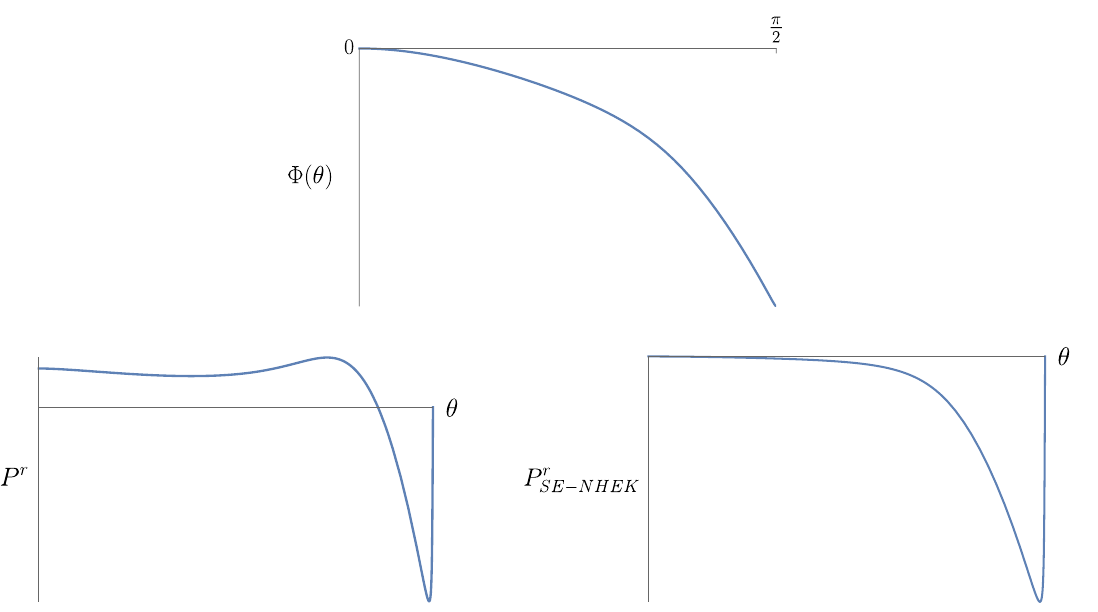
Figure 4 . Solution Φ( θ ) and corresponding Poynting flux P r as a function of θ , for the SE- NHEK log solution with parameter values ‘ = 1 , I 0 = 0 . 9 , ω 0 = 0 . 5 and Ω ext Φ( π/ 2) = − 0 . 68 . The last figure shows the flux measured by a non-rotating SE-NHEK